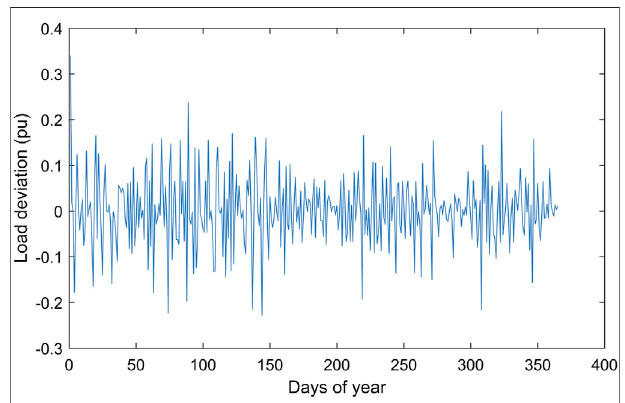
FIGURE 2 | Load deviation of power system for one-year period.